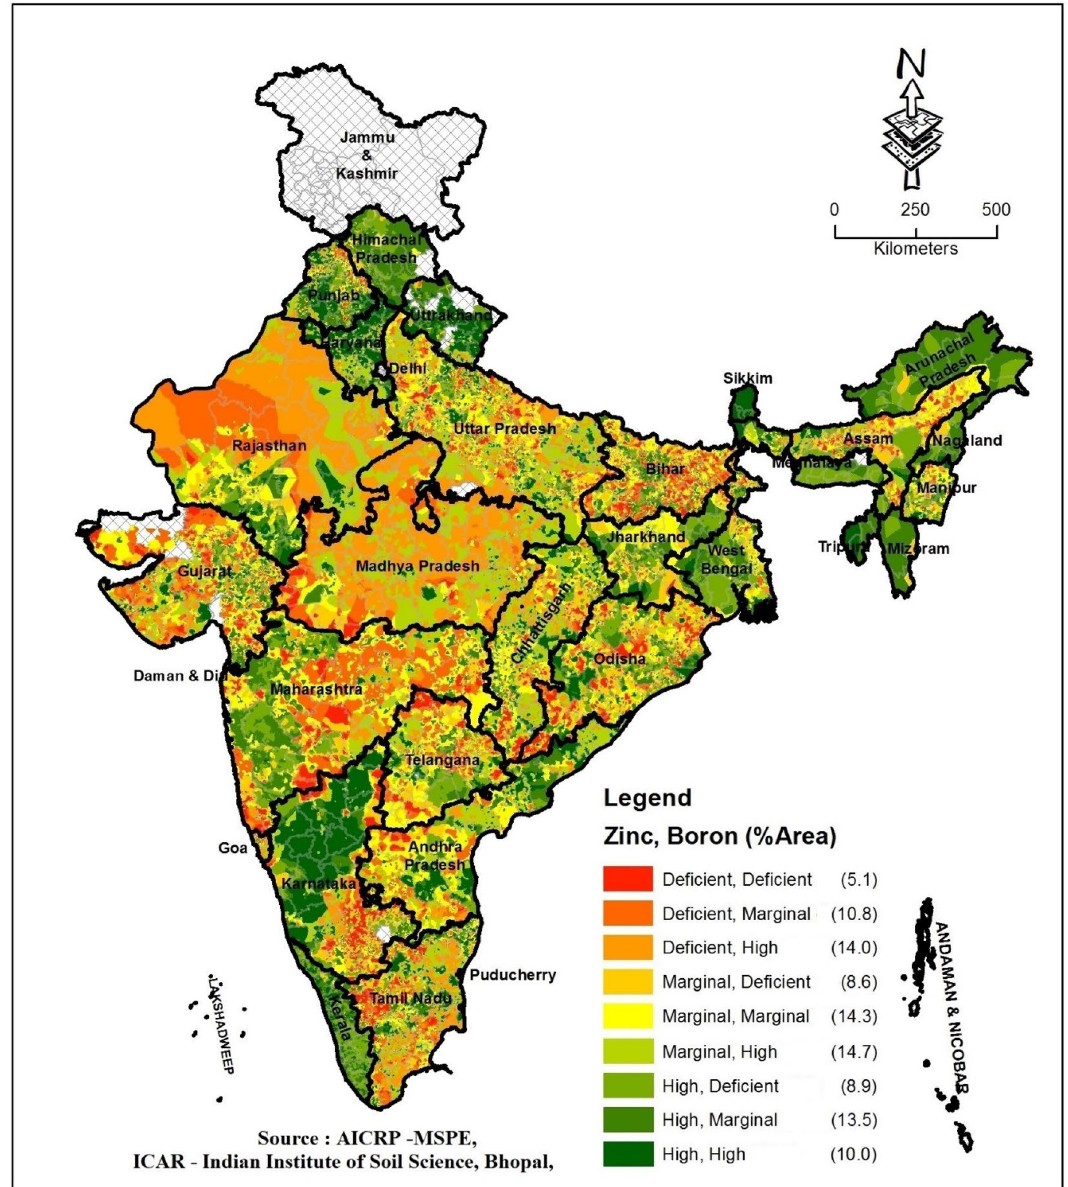
Figure 1. Spatial distribution of Zn + B deficiency in different states of India (The figure has been prepared using ArcGIS software (version 10.5.1), Environmental Systems Research Institute, Redlands,